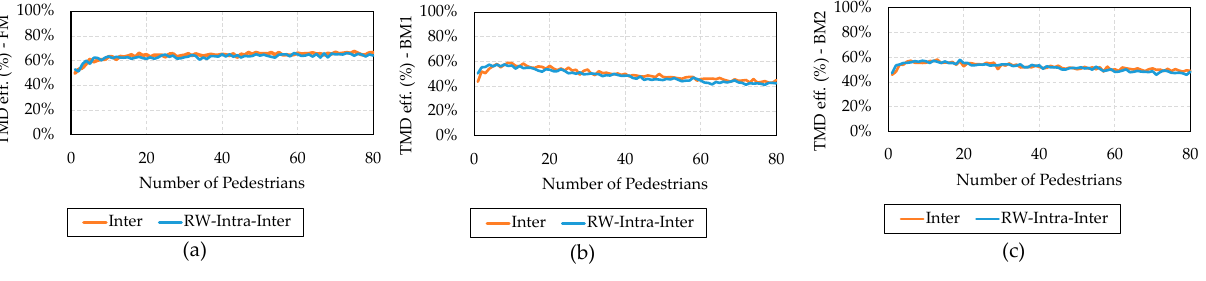
Figure 9. The TMD efficiency of the RW-intra-inter scenario. ( a ) FM, ( b ) BM1, and ( c ) BM2. ferent from the BM, and similar to the previous analyses. The TMD efficiency starts with the same pattern in all models, but after the number of pedestrians is increased, the be- havior of the response is modified: the FM remaining practically constant and the BMs having a steady decrease, as expected.